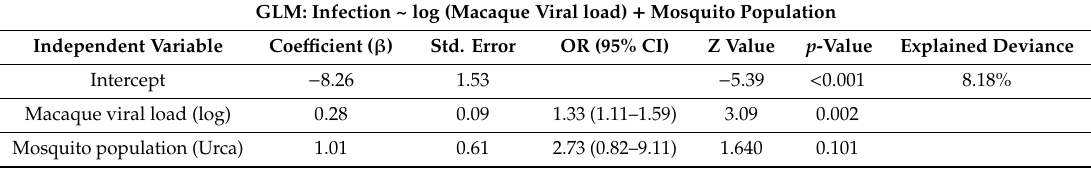
Table 2. Generalized linear models (GLMs) with binomial distribution showing the influence of macaque viral load (log) on Aedes aegypti Zika virus